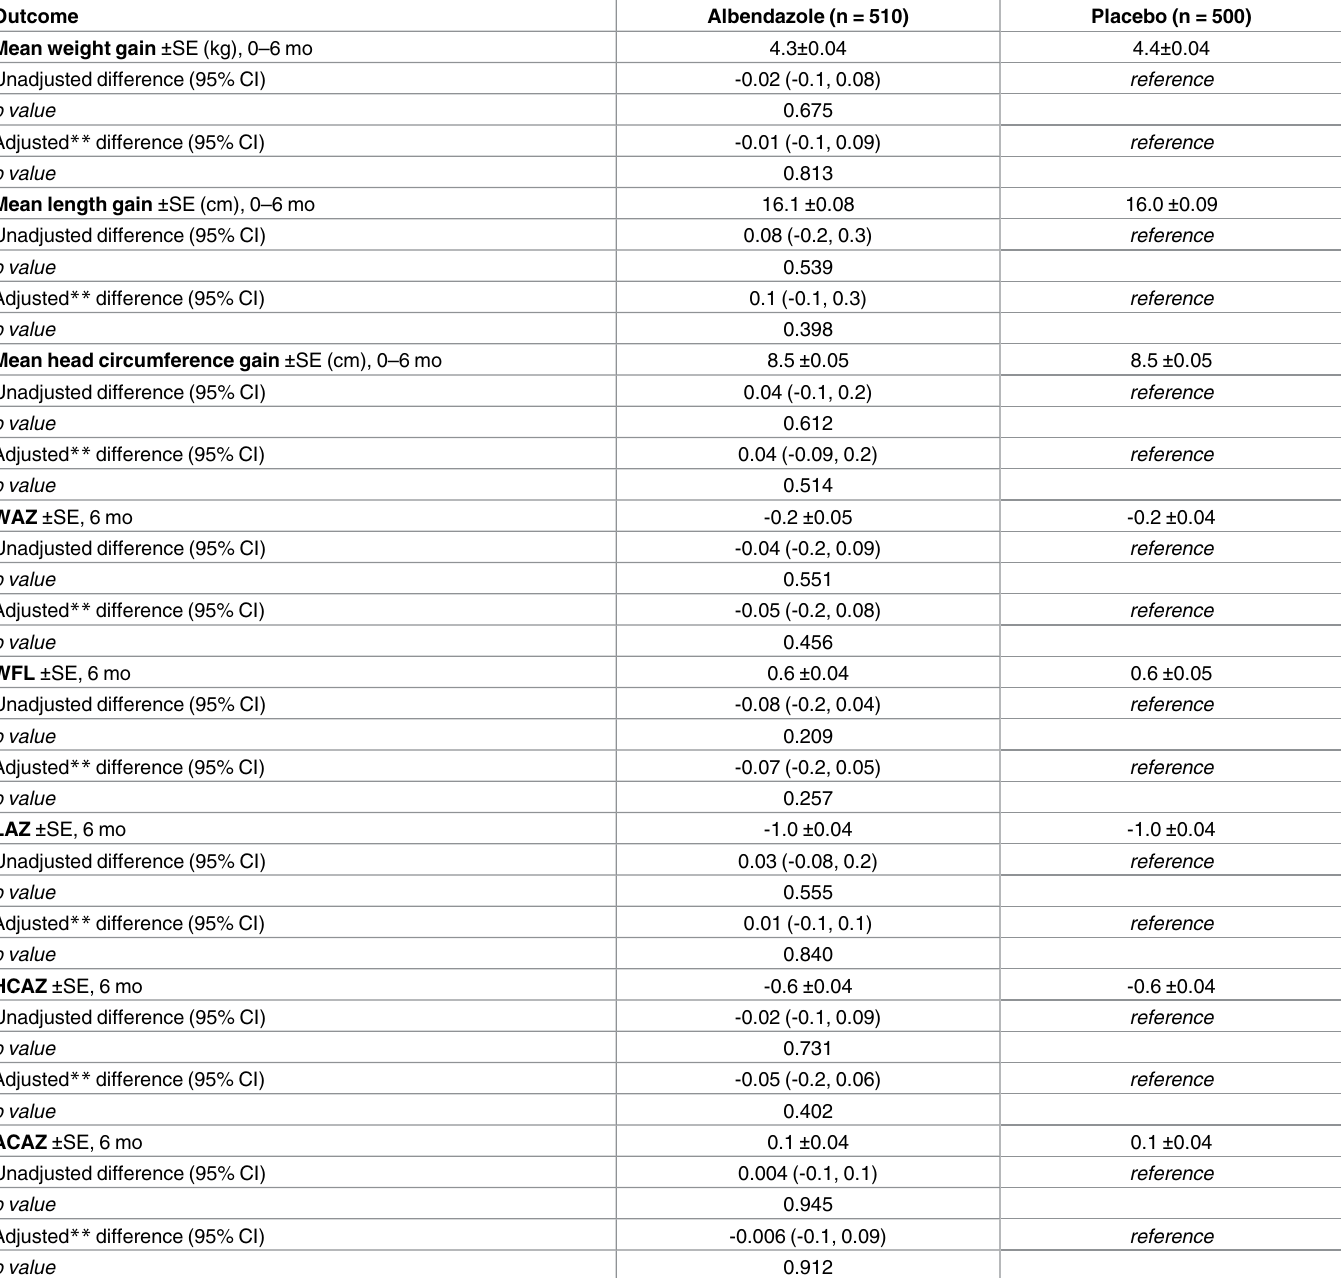
Table 3. Effect of maternal postpartum deworming on infant anthropometric outcomes over their first 6 months of life (N = 1010 * ),Iquitos, Peru (February 2014 –February